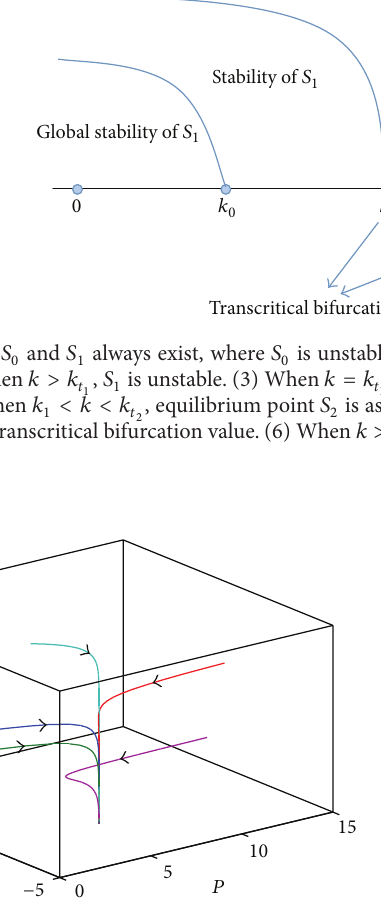
Figure 3: The stability of the equilibrium 𝑆 1